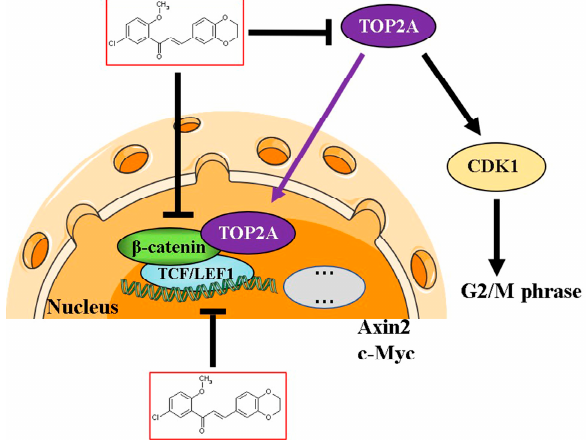
Figure 7. Potential mechanism of action. The chalcone derivative CX258 may inhibit the Wnt signaling pathway by modulating β -catenin levels, nuclear translocation and β -catenin’s activity in Wnt target gene transcription. In addition, CX258 inhibited the expression of TOP2A, reduced the expression of CDK1, induced cell cycle arrest of CRC cells at the G2/M phase, and ultimately inhibited CRC growth.